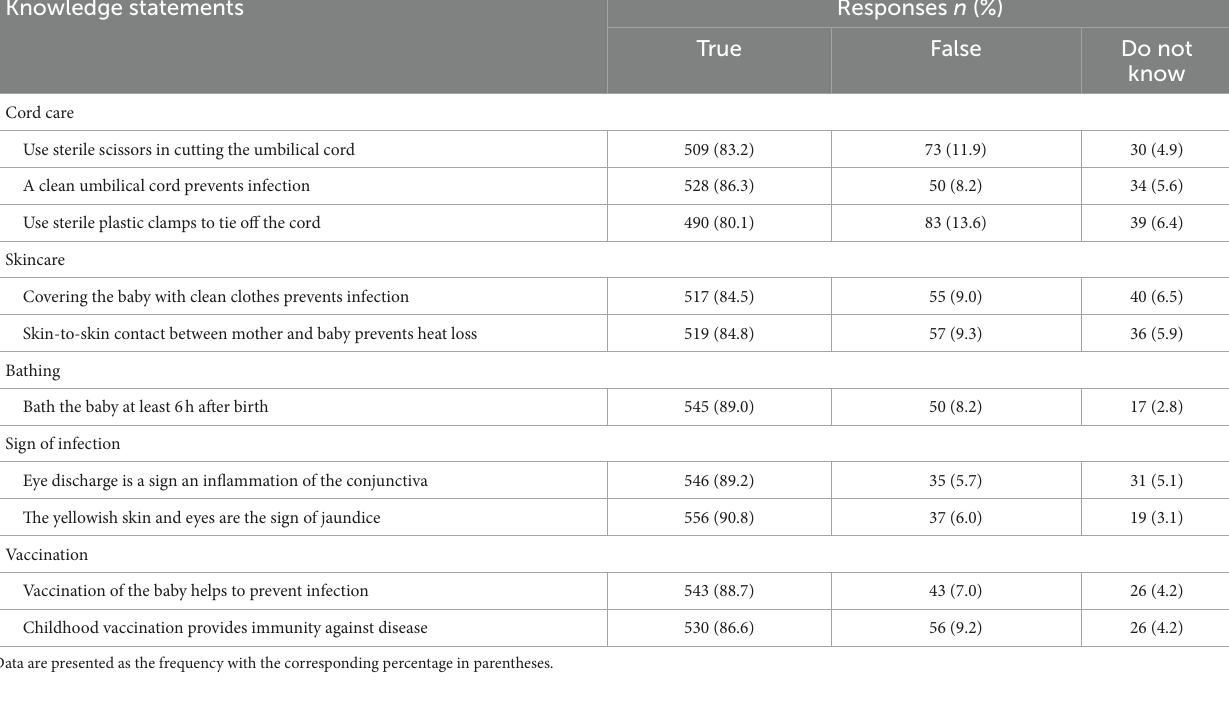
TABLE 3 Practices of infection prevention in neonates ( n =